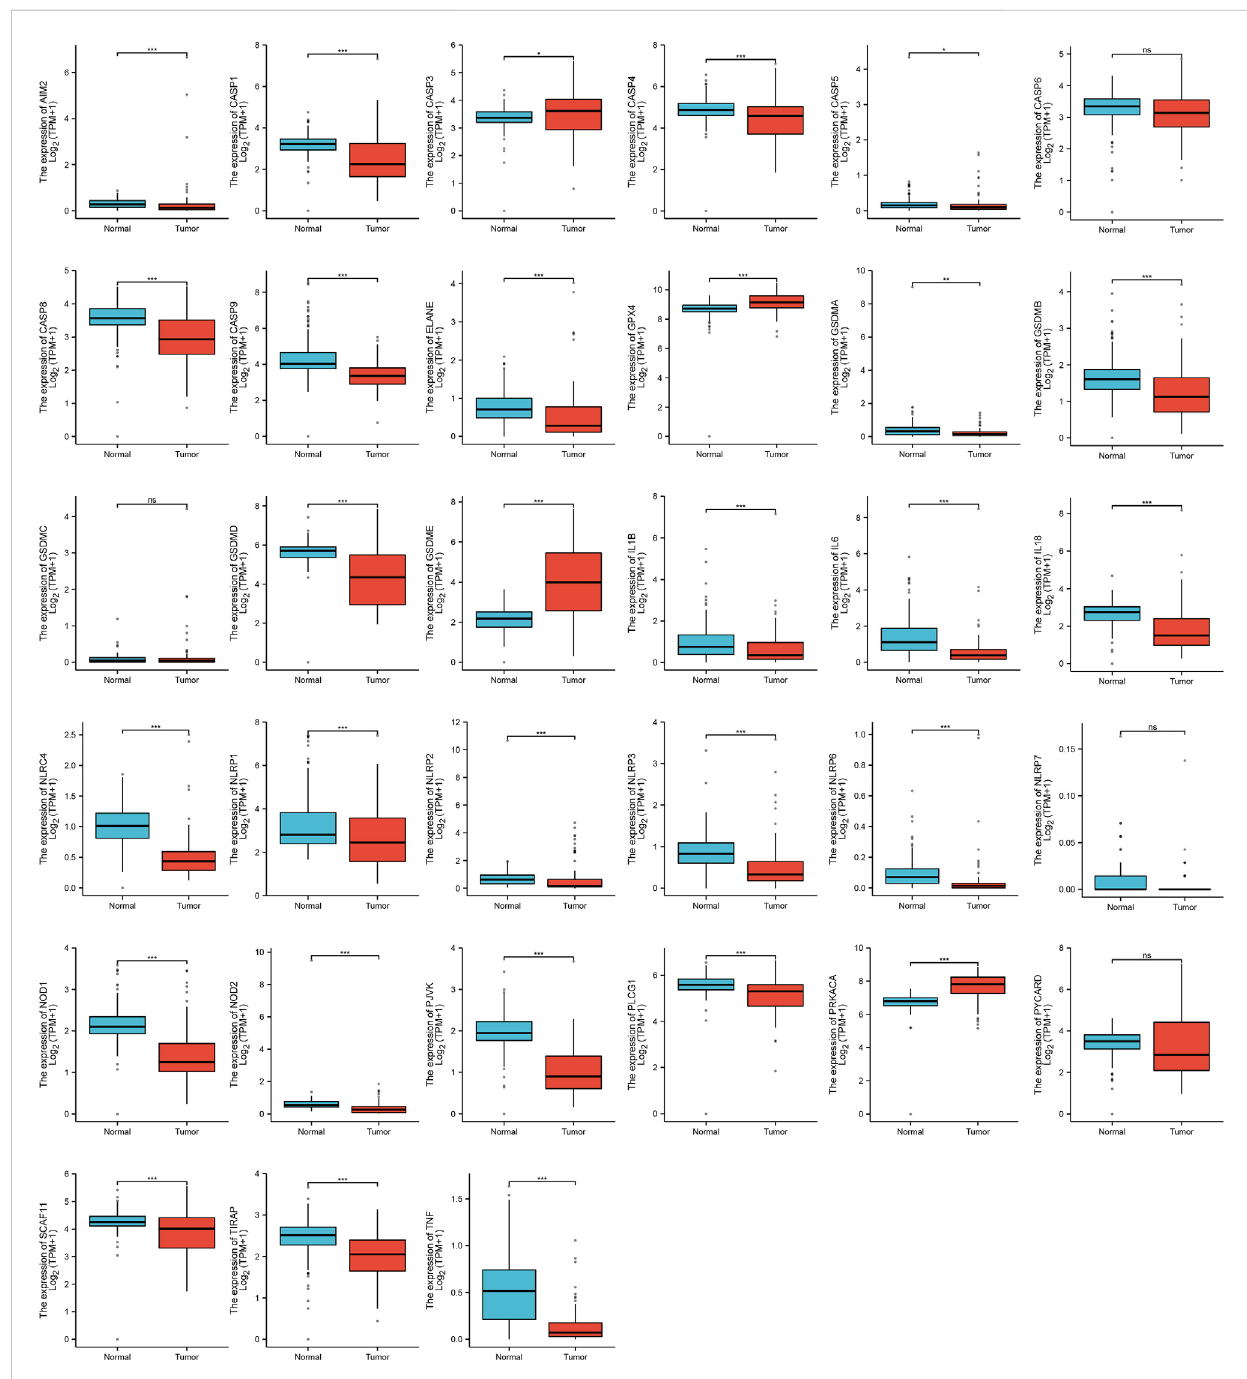
FIGURE 1 The expression of PRGs in ACC. [* p < 0.05, ** p < 0.01, *** p < 0.001, asterisks (*) stand for signi fi cance